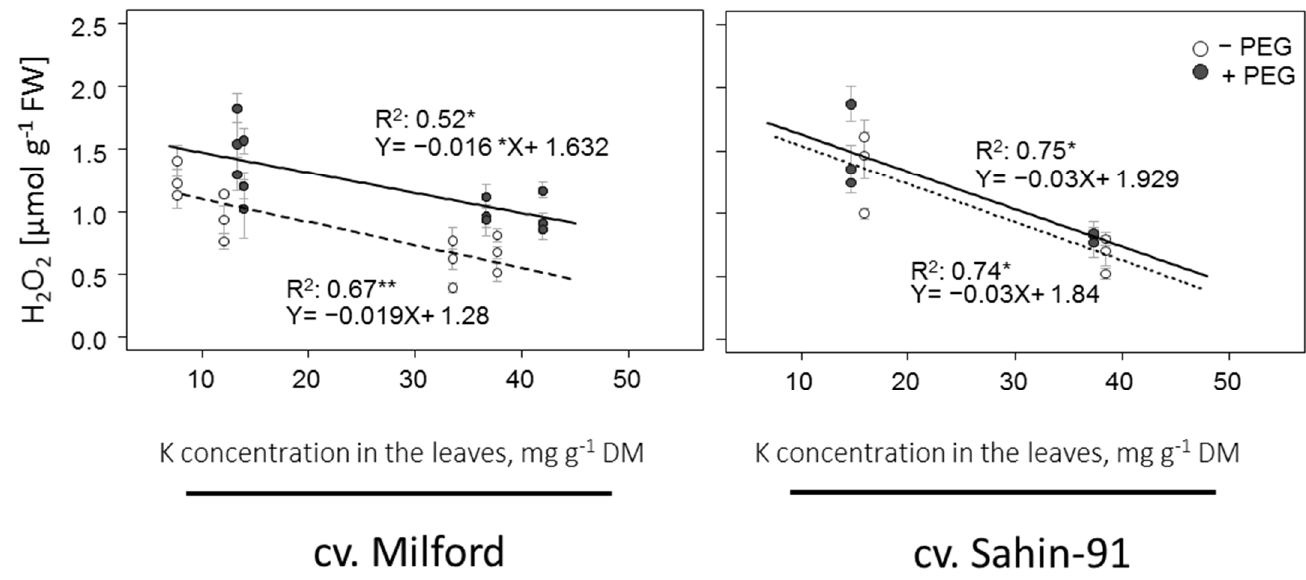
Figure 1. Relationship between H 2 O 2 and K concentrations in the fully expanded young leaves of two barley cultivars (Sahin-91 and Milford) grown under osmotic stress (filled circles) and no osmotic stress (open circles). Standard errors are depicted on the symbols ( n = 3). Stars on r squared values show the significance at the level of 0.05 (*) and 0.01 (**).